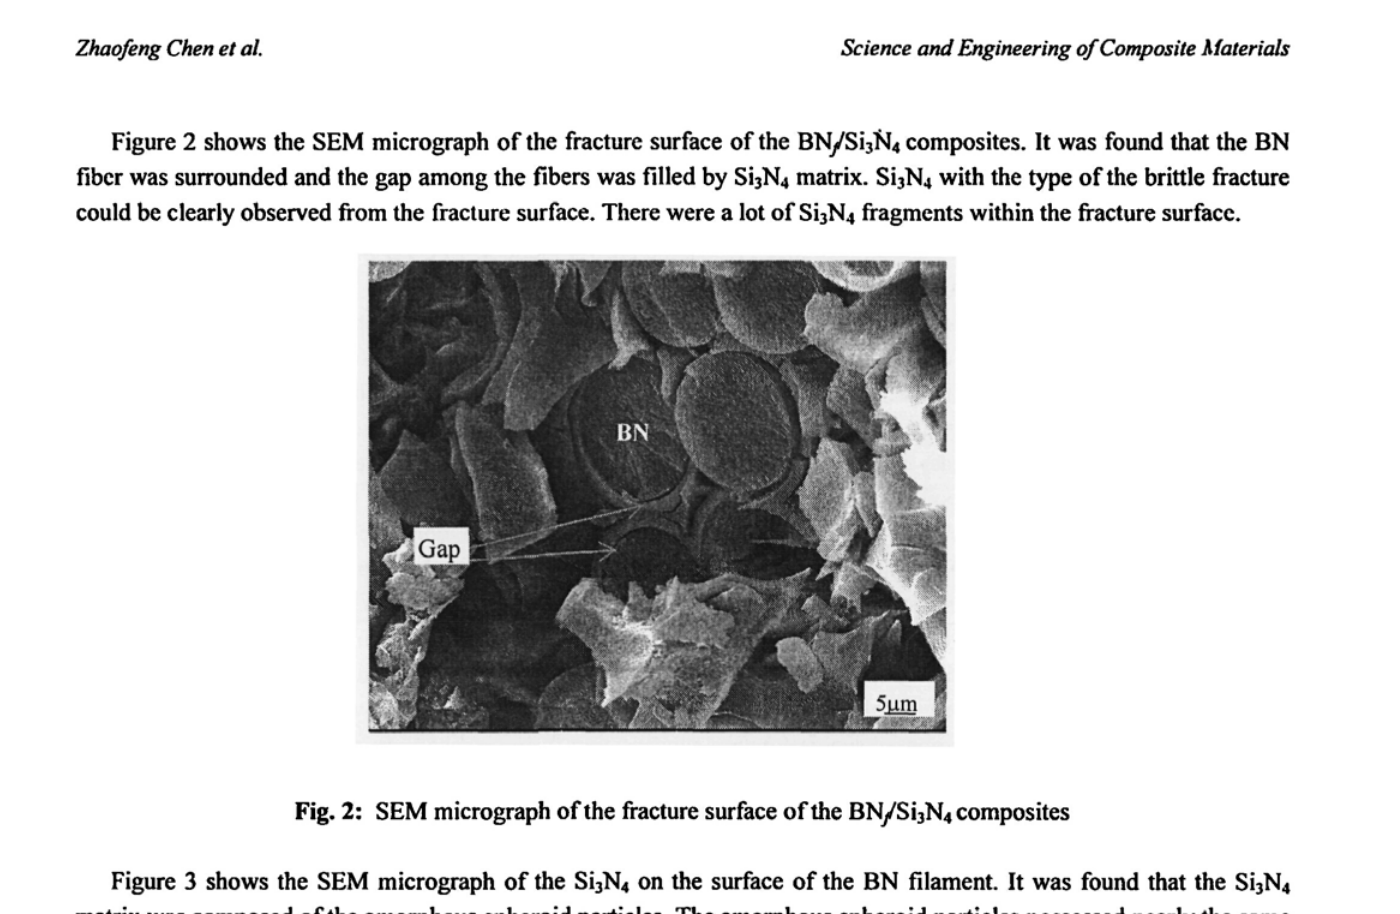
Fig. 2: SEM micrograph of the fracture surface of the BN/Si